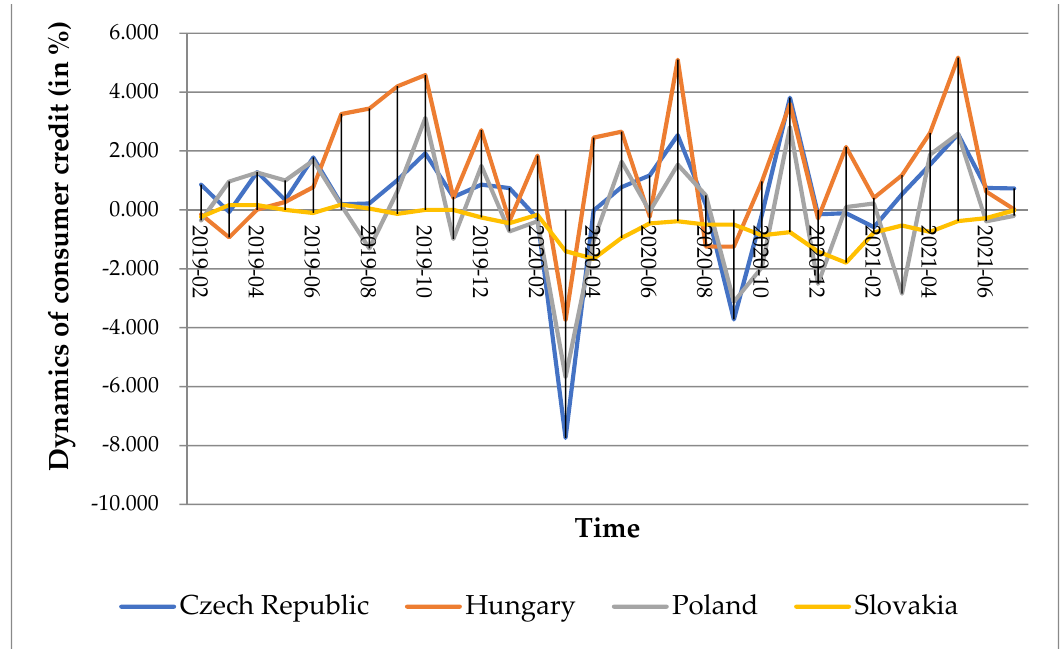
Figure 3. Dynamics of consumer credits in V4 countries (month/month). Source: (https://sdw.ecb.europa.eu/browse.do?node=9691311accessed on 25 September 2021).